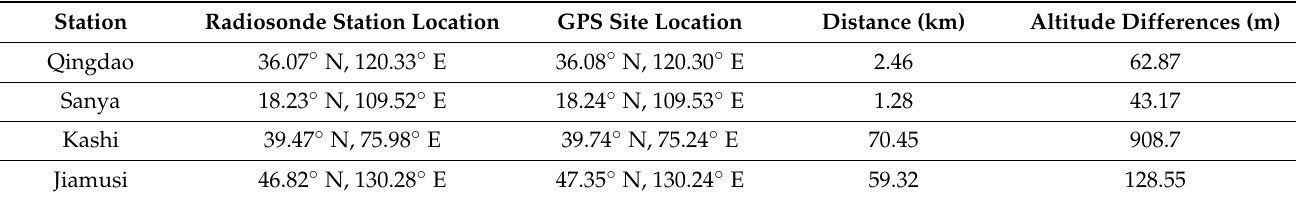
Table 1. The location of radiosonde stations and GPS observations sites of Qingdao, Sanya, Kashi, and Jiamusi. Station Radiosonde Station Location GPS Site